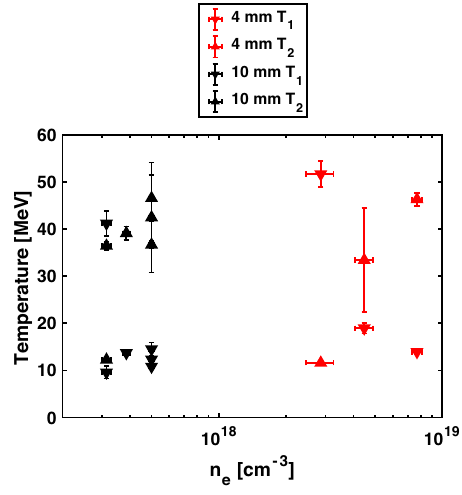
FIG. 3. All the measured hot (cold), T 1 ( T 2 ) temperatures for the 4 (10) mm gas jet nozzles used in the experiment following the same analysis described in the main text body.